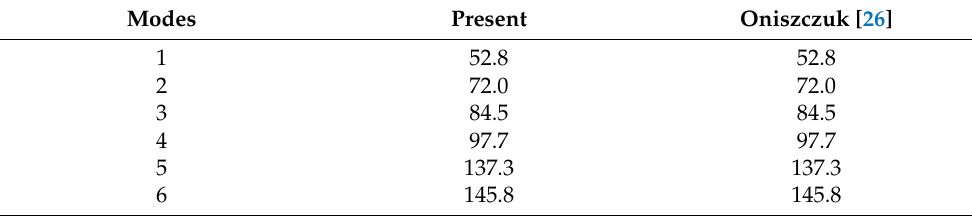
Table 2. Comparison of the natural angular frequencies of the double-plate system.